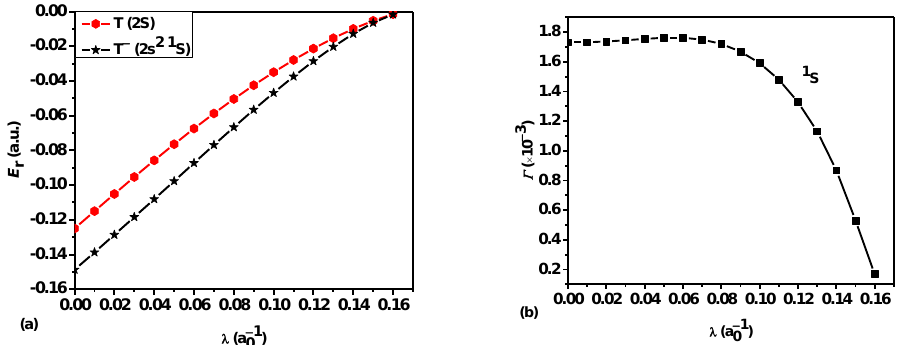
Figure 8. ( a ) Lowest 1 S e resonance energy 𝐸 𝑟 of T − as a function of 𝜆 . ( b ) Resonance width 𝛤 of T − as a function of 𝜆 .